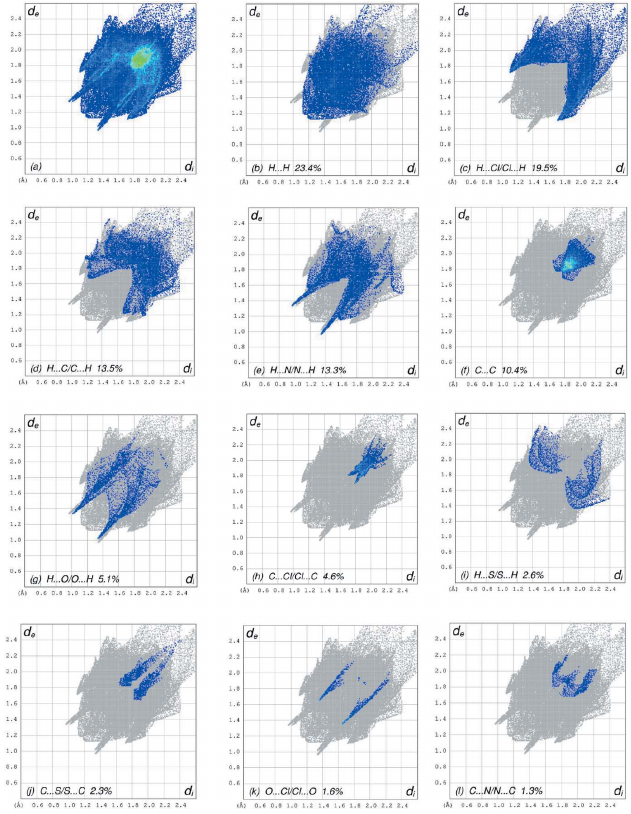
(McKinnon et al. , 2007) are illustrated in Fig. 7 b – l , respec- tively, together with their relative contributions to the Hirsh- feld surface. The most important interaction is H (cid:2) (cid:2) (cid:2) H (Table 2), contributing 23.4% to the overall crystal packing, which is reflected in Fig. 7 b as widely scattered points of high density due to the large hydrogen content of the molecule with the small split tips at d + d = 2.32 A˚ . The pair of wings in the e i fingerprint plot delineated into H (cid:2) (cid:2) (cid:2) Cl/Cl (cid:2) (cid:2) (cid:2) H contacts (19.5% contribution) have a nearly symmetrical distribution of points, Fig. 7 c , with the thin edges at d + d = 2.82 A˚ . In the e i absence of C—H (cid:2) (cid:2) (cid:2) (cid:2) interactions, the wings in the fingerprint plot delineated into H (cid:2) (cid:2) (cid:2) C/C (cid:2) (cid:2) (cid:2) H contacts (13.5%) also have a nearly symmetrical distribution of points, Fig. 7 d , with the (cid:6) 2.90 A˚ . The wings in the fingerprint + d thick edges at d e i plot delineated into H (cid:2) (cid:2) (cid:2) N/N (cid:2) (cid:2) (cid:2) H contacts (13.3%, Fig. 7 e ) have as pair of spikes with the tips at d + d = 2.30 A˚ . The e i C (cid:2) (cid:2) (cid:2) C contacts (10.4%, Fig. 7 f ) have an arrow-shaped distri- (cid:6) 1.78 A˚ . The H (cid:2) (cid:2) (cid:2) O/ = d bution of points with the tip at d e i